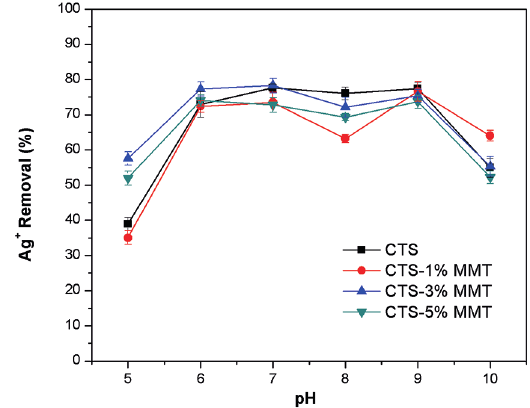
Figure 5: Effect of pH on the Ag + adsorption rate after 150 min (the weight of MMT: 0, 1, 3 and 5% of chitosan solution; Ag + concentration: 10 mg/L; volume: 100